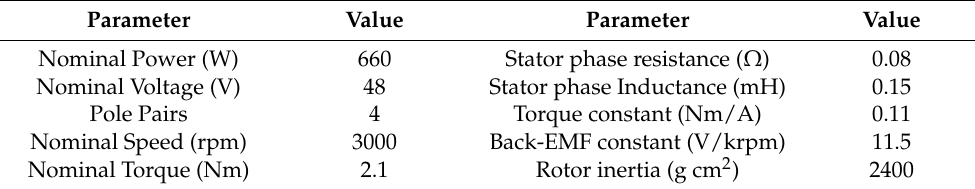
Table 2. Simulation Parameters of the brushless DC